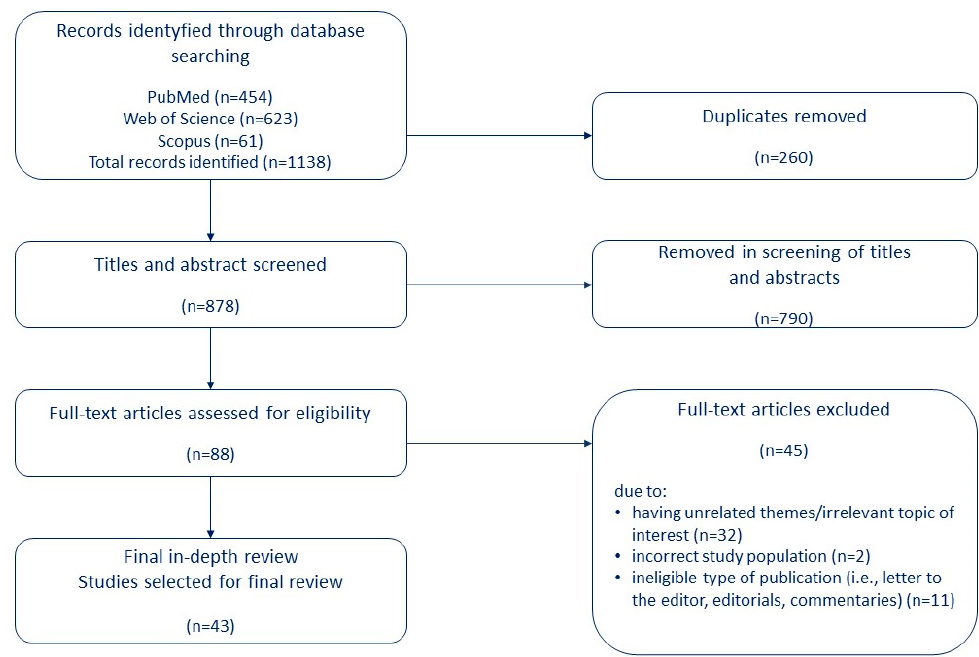
Figure 1. Flow diagram of literature search and study selection.